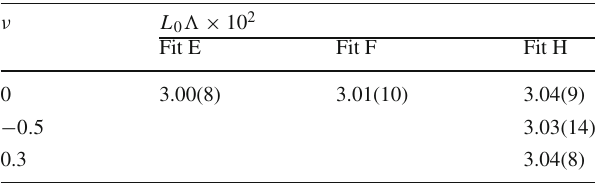
Table 7 L 0 (cid:2) obtained with the fits to the coefficient b fit function, cf. Table 5 and Sect.